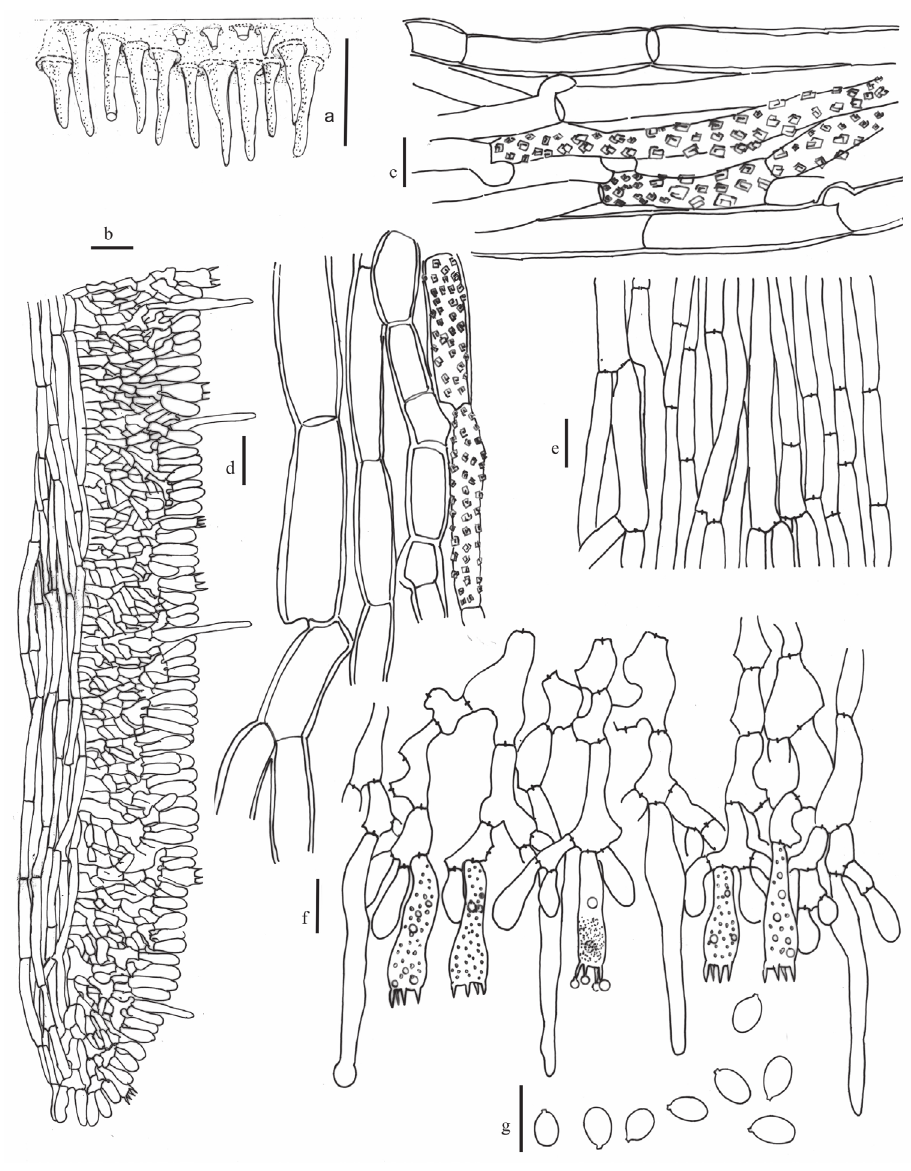
Figure 7. Hydnophlebia gorgonea. Collection 19111Tell., MA-Fungi 86659, holotype a Hymenophore b Vertical section through an aculei c Subicular hyphae d Strand hyphae e Aculei hyphae f Subhymenial hy- phae, cystidia, and basidia g Spores. Scale bars: a = 1 mm; b = 25 μm; c–g = 10 μm. Drawing by M. Dueñas. Description. Basidiome resupinate, effuse, membraneous to ceraceous, yellowish white (92. y White) to pale orange-yellow (73. p. OY) in dry specimens. Hymenophore hydnoid, aculei conical, 0.5−1 mm long, in dried specimens usually broken. Margin fimbriate, yellowish white, with